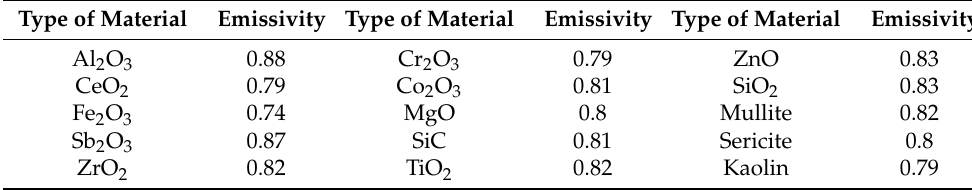
Table 9. Emission rates of common metal oxide and non-metal oxide (5–25 µ m wideband) when temperature is higher than 100 ◦